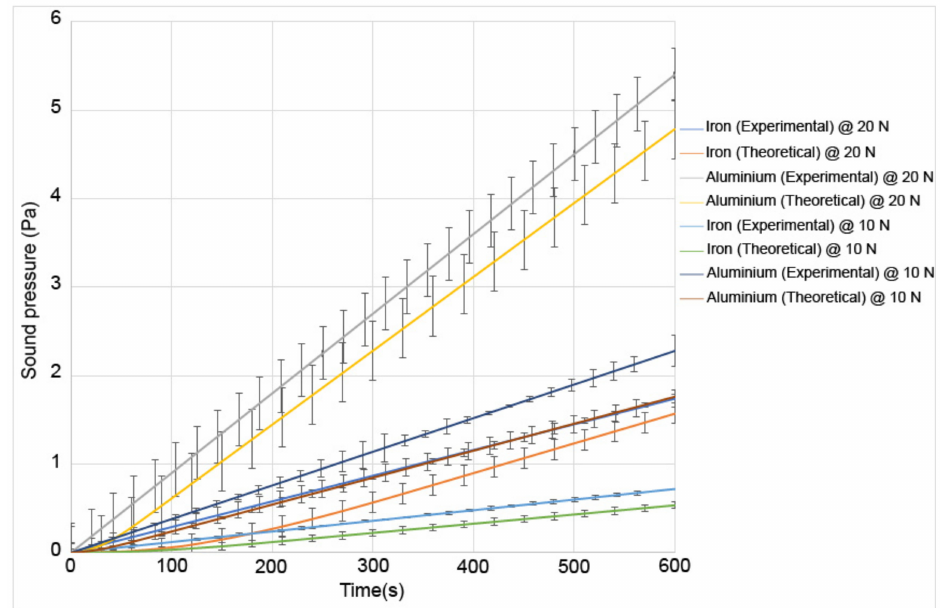
Figure 8. Experimental results for the sound pressure at a 20 N load and 40 ◦ C for aluminium (grey) and iron (blue). Theoretical results at a 20 N load and 40 ◦ C for aluminium (yellow) and iron (orange). Experimental results at a 10 N load and 40 ◦ C for aluminium (violet) and iron (teal). Theoretical results at a 10 N load and 40 ◦ C for aluminium (brown) and iron